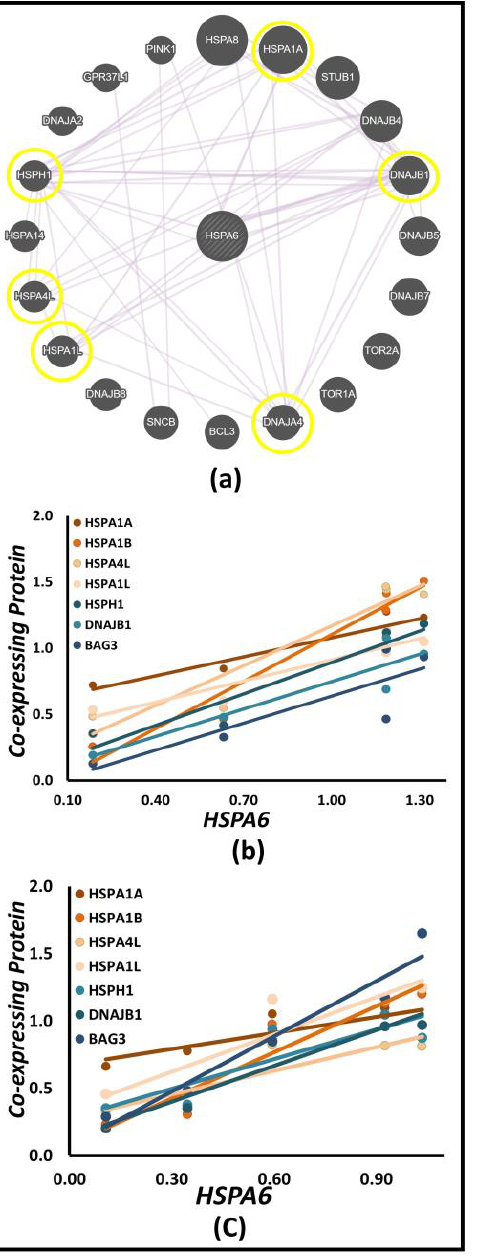
Figure 9. Network Analysis. GeneMANIA diagrams show direct and indirect co-expressed interactions of HSPA6 ( a ) and HSPH1 ( d ). The straight lines connecting the genes indicate all potential co-expressions, and the circled genes exist in the present study. Co-expression plots for HSPA6 ( b , c ) and HSPH1 ( e , f ) in SH-SY5Y and differentiated SH-SY5Y cells, respectively. Highly significant protein level co-expression is observed with r ≥ 0.95 in almost all the analyzed co-expressions for HSPA6 and HSPH1. (Table S2: Pearson correlation coefficients ( r ) and p -values for the co-expression analysis of HSPA6 and HSPH1. Figure S7: GeneMANIA diagram showing co-expressed interactions of HSPA1A, HSPA1B, HSPA4L, and HSPA1L).